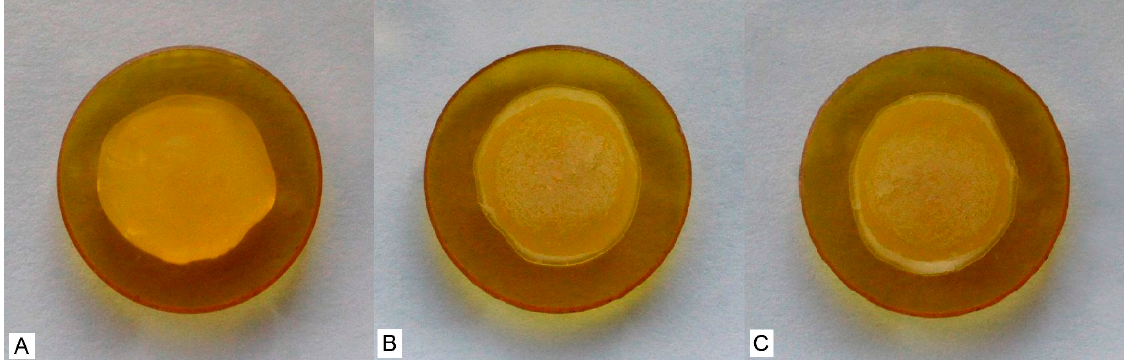
Figure 2. Photographs of aqueous suspension of A. brasilense Sp7 bacterial biomass freshly applied to a ZnSe glass ( A ), dried for 1.5 h ( B ) and for 23 h ( C ).